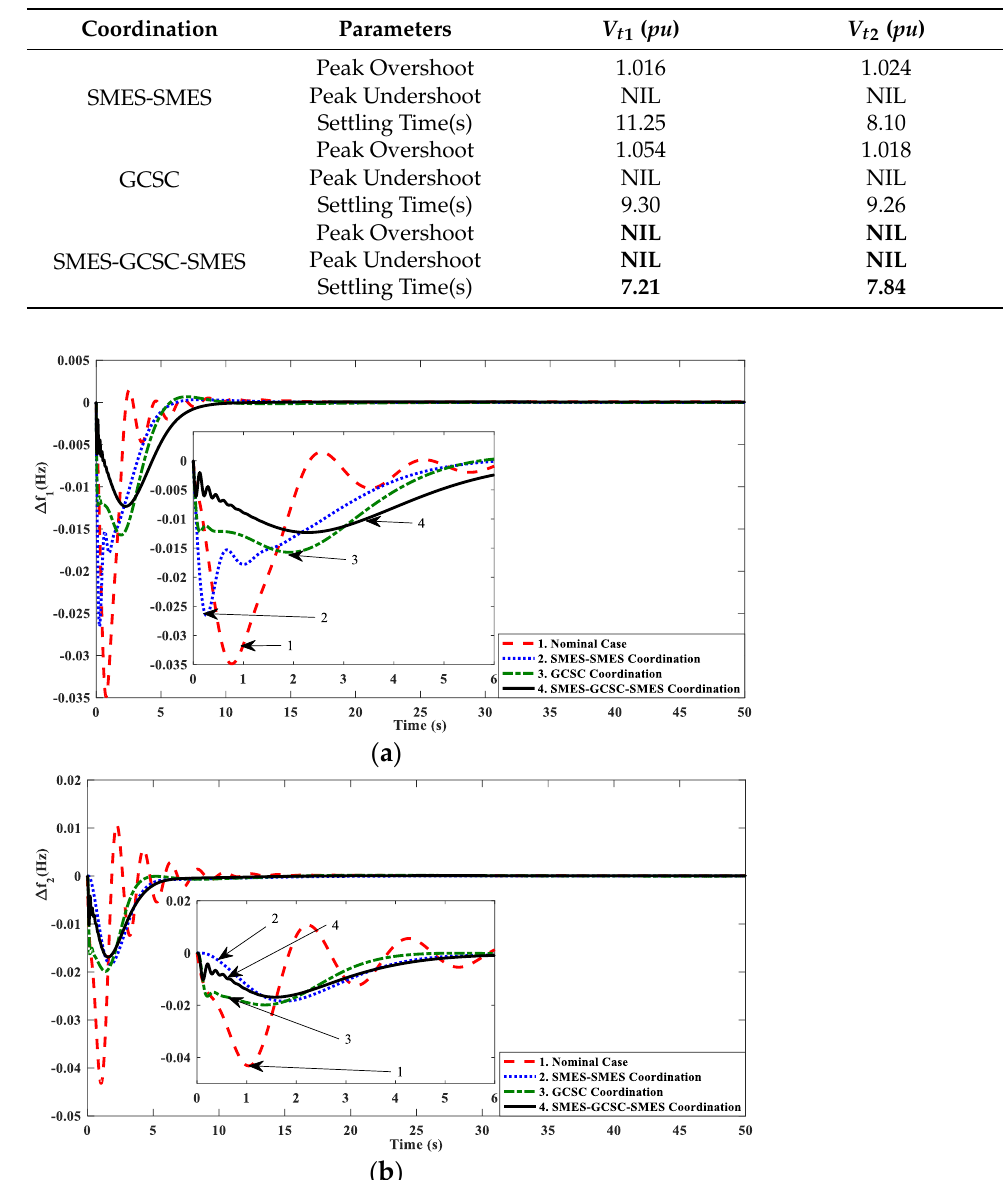
Table 15. Numerical values of T s ( s ), M P , and U P for AVR.